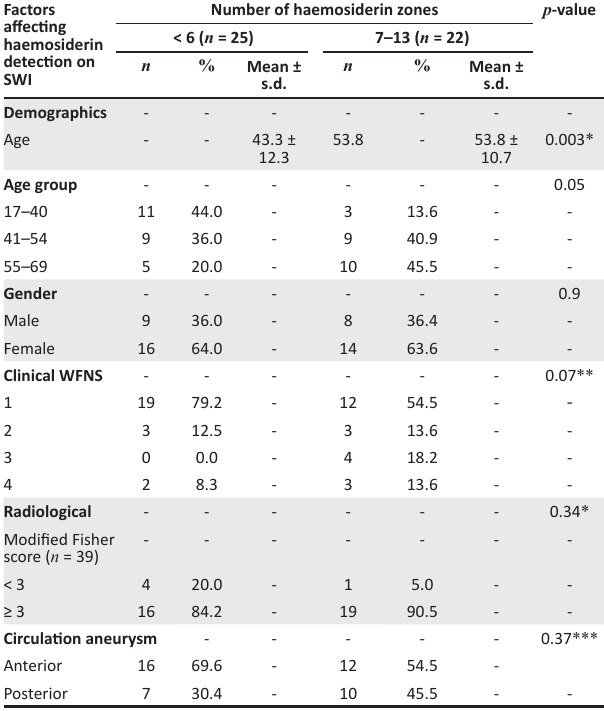
Number of haemosiderin